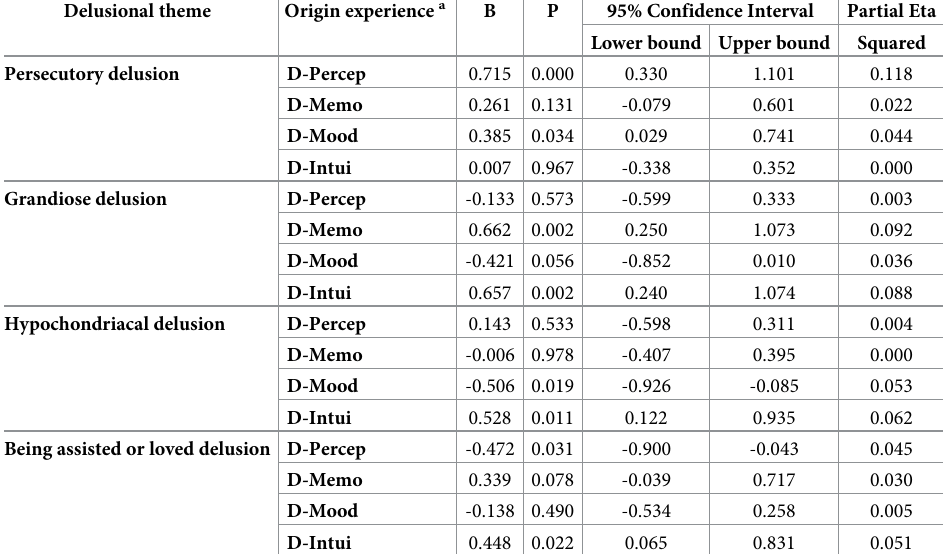
Table 5. Multivariate analyses of covariance (MANCOVA) regression of DOAI delusion themes with primary delusions (PDs).